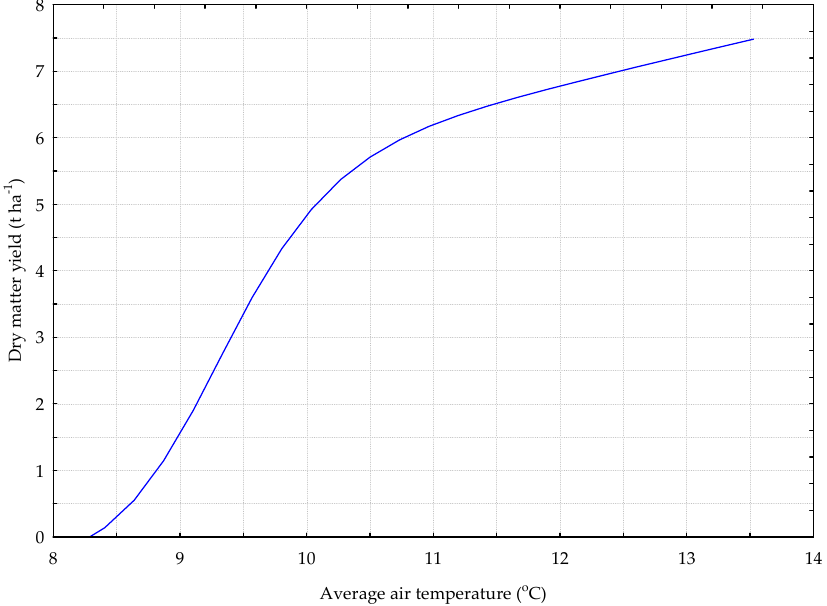
Figure 10. The Y_GC model. The response chart for variables T_AV (rank 1) and Y_DM. Figure 11 shows the data referring to the dependence between the percentage of digestibility of the dry matter from the sward with the predominance of grasses and red clover (DIG_GC model). An increase in the percentage share of legumes (%_L) caused an increase in the digestibility of the green forage dry matter.